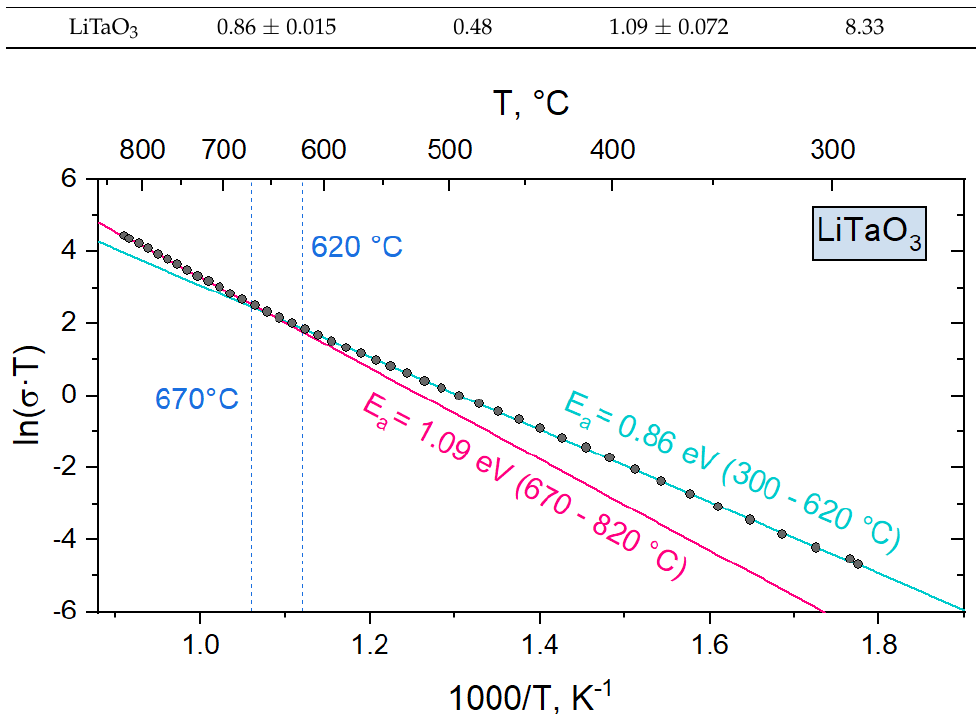
Figure 15. ln( σ · T) vs. 1000/T dependence of LiTaO 3 samples (dots) and linear fits of its separate regions (lines). Table 4. Activation energies E A and pre-exponential coefficients σ 0 for conductivity of LiNb 1 − x Ta x O 3 pressed pellets at different temperatures.